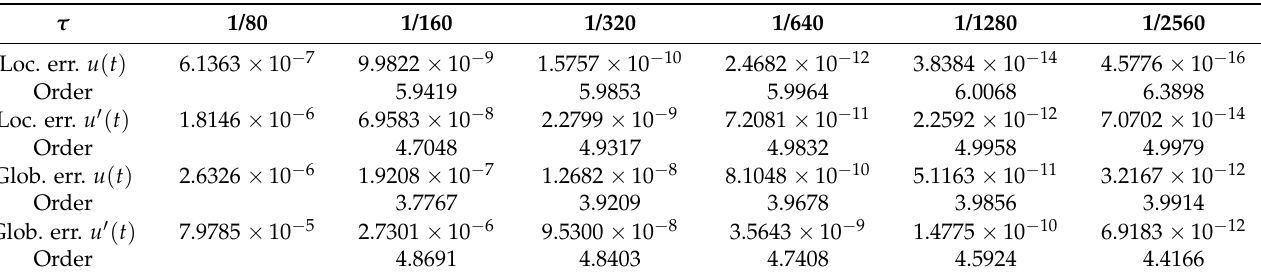
Table 3. Local and global errors and orders for problem (2) with